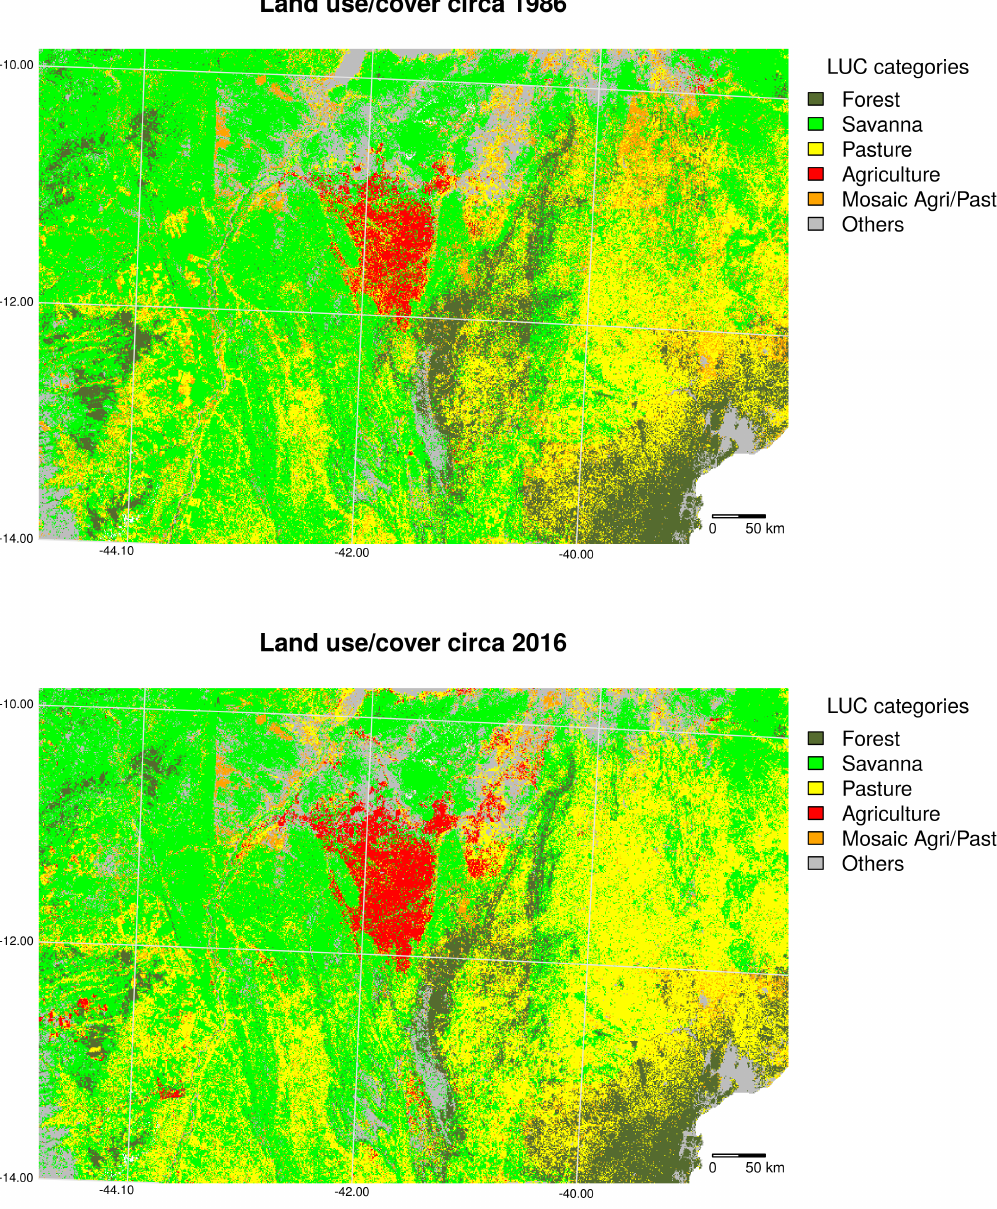
Figure 3. Land use/cover (LUC) distribution at the beginning and at the end of the time